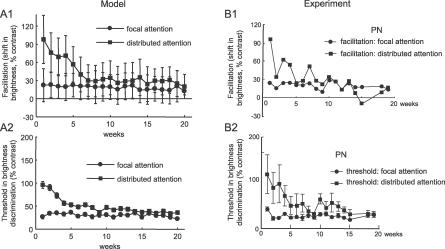
Learning Curves from the Model (A) and the Experiment (B), Reproduced from [1]Training (600 trials per week) reduces the facilitation in brightness perception by a flanking bar (A1, B1) and reduces the threshold in brightness discrimination (A2, B2). In the model, the learning progress is achieved through LTP at synapses from the attentional centers to the task neuron (cf. Figure 3). Increased drive of the task neuron in turn activates the inhibitory neurons and increases the gain of the V1 pyramidal neurons. This explains the reduction in the brightness facilitation and in the discrimination threshold, respectively. Experimental data (adapted from [1]) are from one human subject. Error bars here and in the following figures indicate the standard error of the mean (not shown in B1).